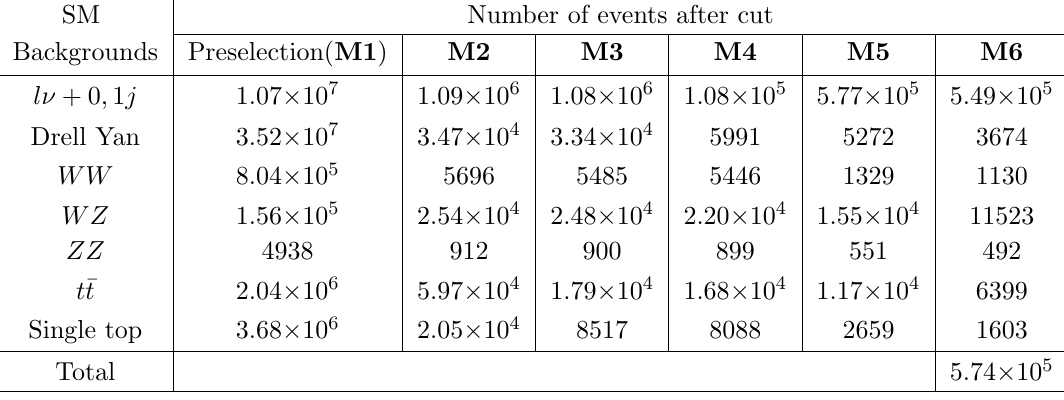
Table 7 . Mono-lepton + missing energy signal (cid:12)nal state number of events at 100 fb (cid:0) 1 for SM background. Note that the events have been rounded-o(cid:11) to the nearest integer. Cross-sections scaled with K-factors at NLO [178] and wherever available, NNLO [191{196] have been used.